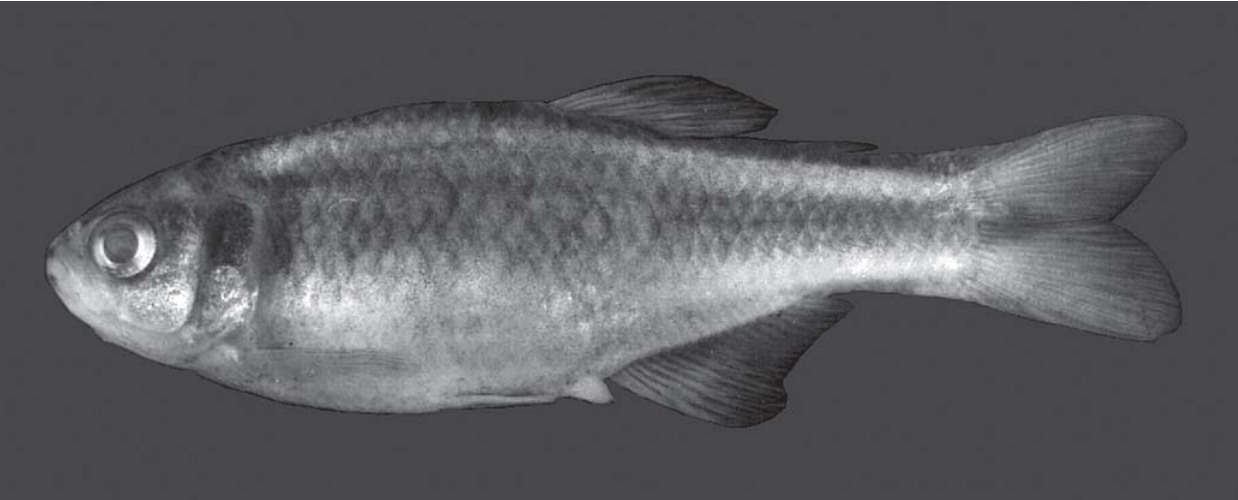
Fig. 21. Glandulocauda caerulea , adult female, USNM 326756, 41.0 mm SL, Brazil, Paraná State, brook tributary to rio Iguaçu near Lara Maria